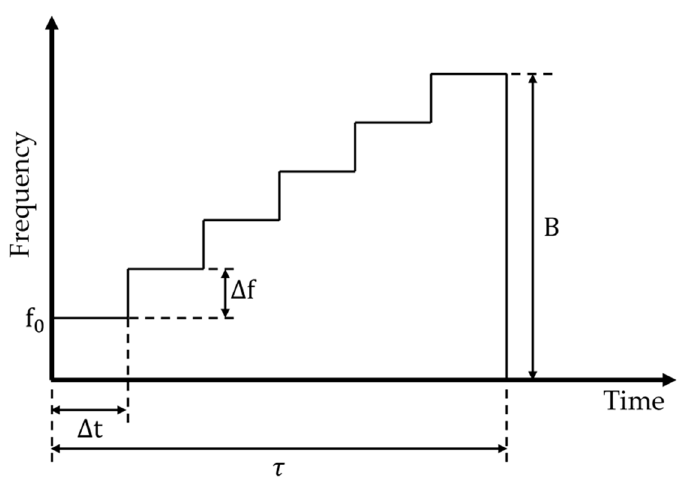
Figure 2. Example of continuous wave stepped frequency (CWSF) signal.